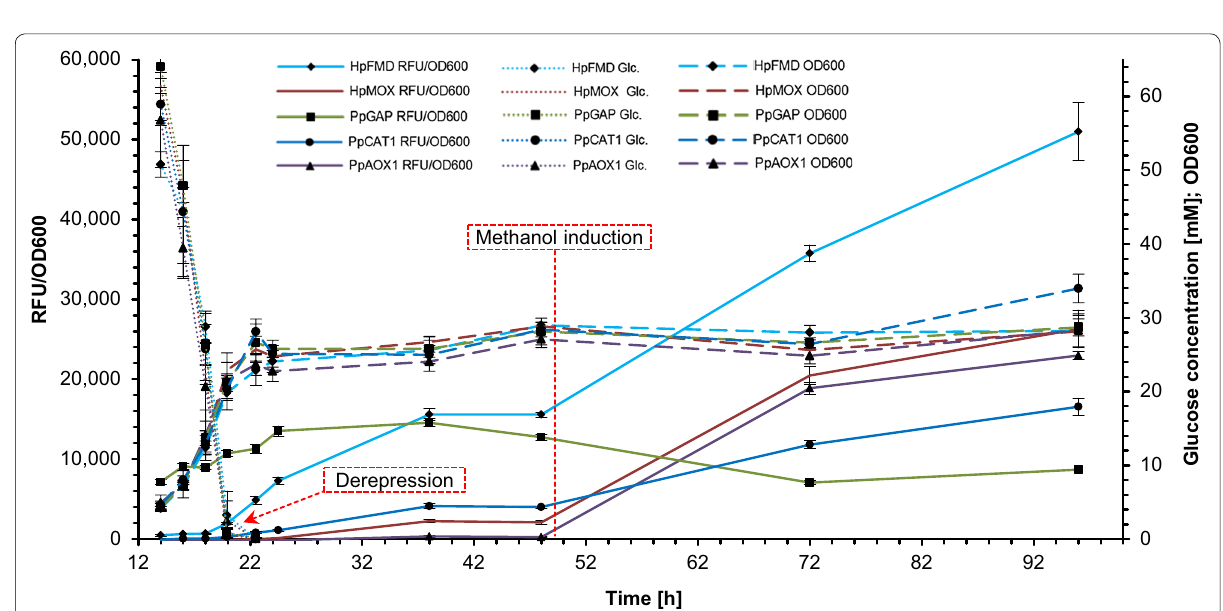
Fig. 2 P HpFMD enables strong derepression and exceeds the strength of methanol induced endogenous P. pastoris promoters. Strains bearing selected promoters from Fig. 1 ( HpFMD , HpMOX , PpAOX1 , PpCAT1 , PpGAP ) were cultivated in shake flasks and inoculated to a low starting OD 600 of 0.05. Reporter protein fluorescence, OD 600 and glucose levels were measured. Fluorescence/OD 600 values at t OD 600 of 0.05 was outside the linear range of the spectrometer used. The initial glucose concentration of the media was 55.5 mM (10 g/L). MVs and SDs of biological triplicates are